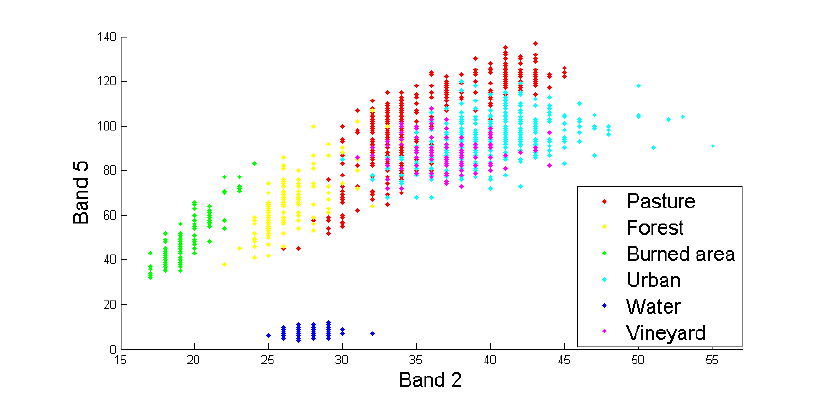
Figure 6: The scatter plot of the test samples with the reference labels for the Sardinia